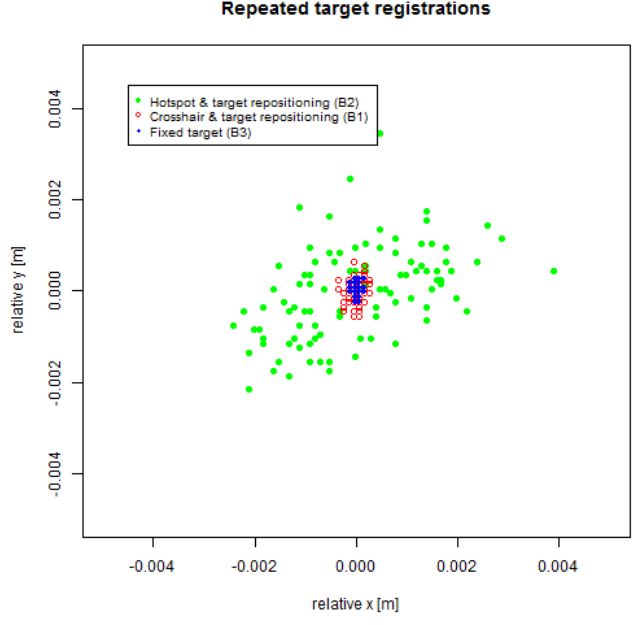
Figure 18. Distribution of manually measured target positions for the benchmark tests (B1–B3). Measured positions are plotted in relation to their averaged centers.